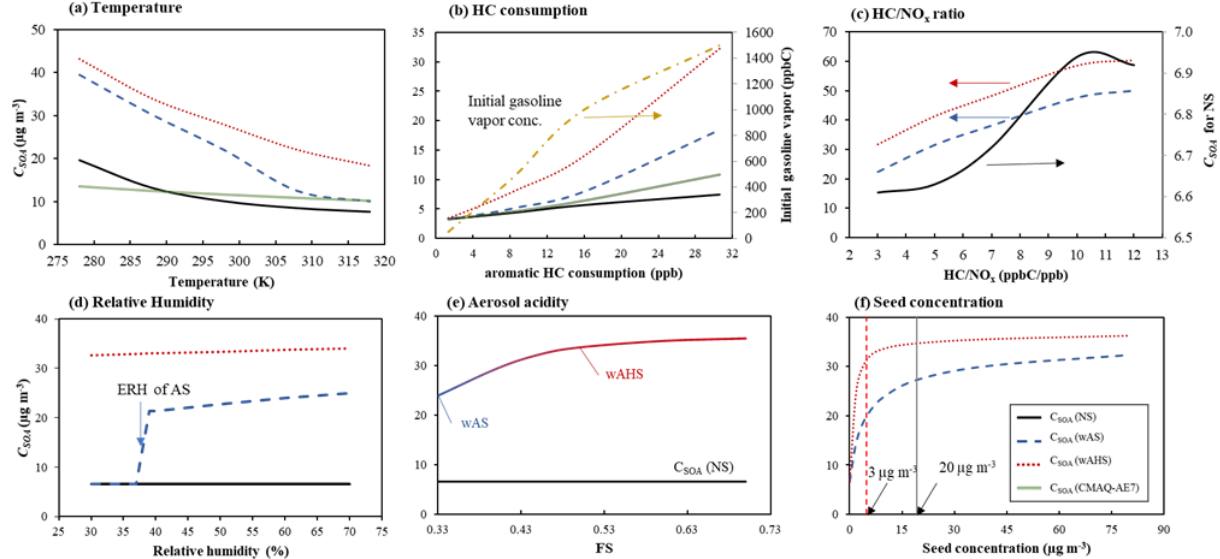
Figure 6. Sensitivities of simulated gasoline SOA mass to (a) temperature, (b) aromatic HC consumption, (c) HC / NO x ratio, (d) relative humidity, (e) aerosol acidity, and (f) seed concentrations. SOA mass is simulated at the high NO x level (HC / NO x = 3ppbCppb − 1 ) under given reference conditions (298K, 60%RH, and 1500ppbC of gasoline vapor) under the specific sunlight intensity measured on 19 June 2015 (Fig. S5a). The concentrations of OM 0 and inorganic seed are 3 and 10µgm − 3 , respectively. The simulated SOA mass using UNIPAR- CB6r3 was compared to that using CMAQ-AE7 module in panels (a) and (b)